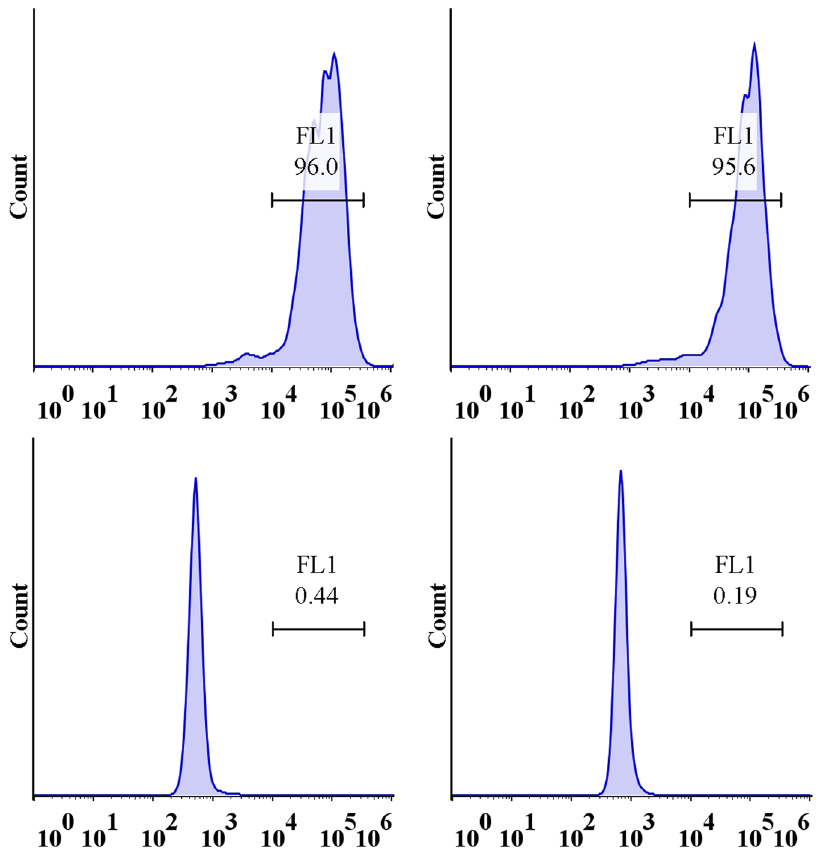
Figure 1. The cell surface antigens of BMSCs were detected by flowcytometer. Positive expression of CD29 + (96.2%), CD90 + (95.9%) and negative expression of CD34 − (0.38%), CD45 − (0.18%) were